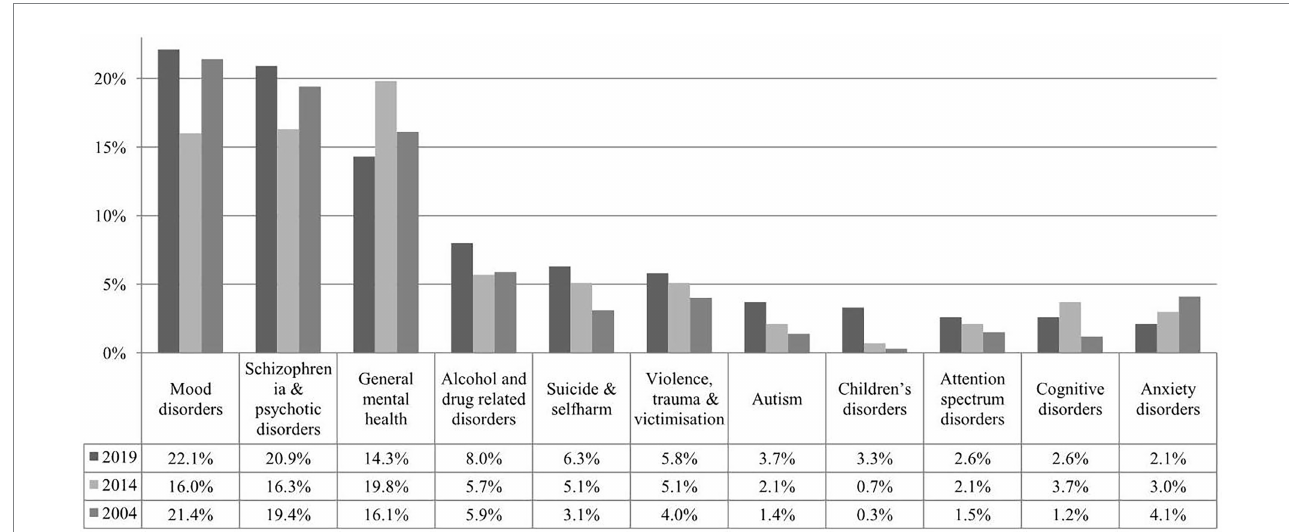
FIGURE 1 Percentages of articles by mental health condition and target population under study in 2004, 2014 and 2019. For each year, percentages were calculated for each category, by dividing the number of that condition by the number of all codes assigned to the conditions ( n = 574 in 2019, n = 724 in 2014 and n = 948 in 2004).